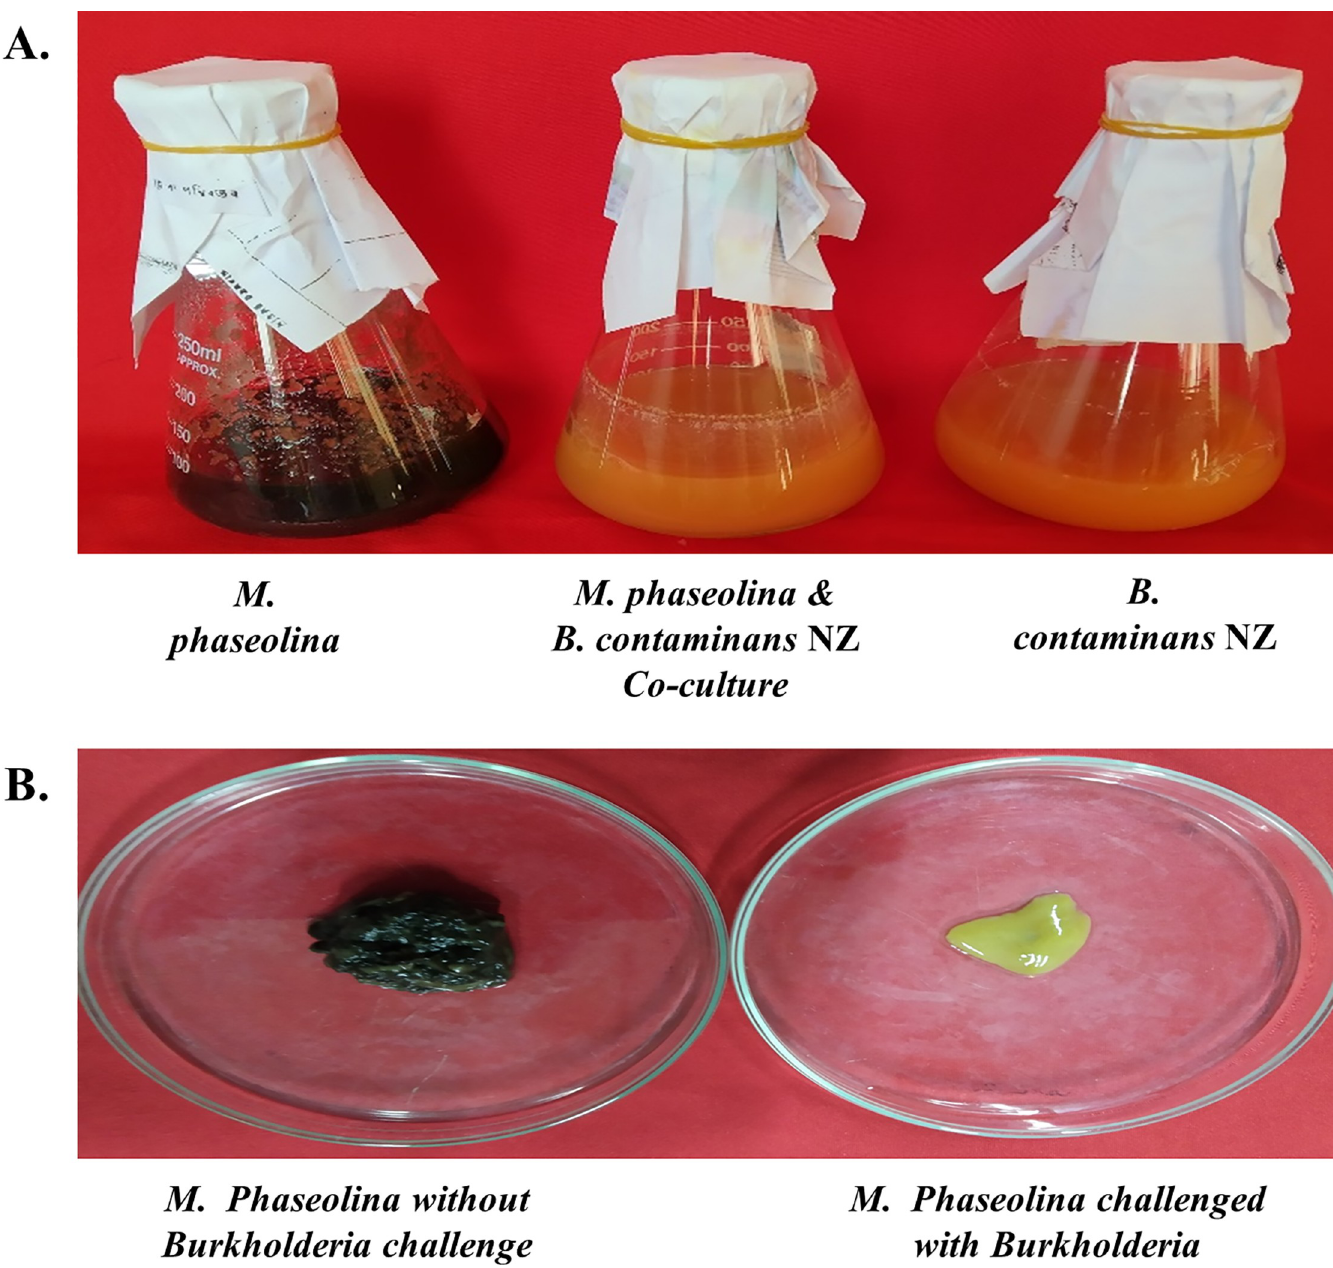
Fig 3. Chromogenic aberration in B . contaminans NZ challenged M . phaseolina . (A) M . phaseolina , B . contaminans NZ, and their co-cultures on day 5. (B) M . phaseolina without B . contaminans NZ retains the black color (left) compared to its B . contaminans NZ challenged counterpart (right). Inhibition of M . phaseolina growth and its pigmentation in the presence of B . contaminans NZ is evident compared to the culture containing only M . phaseolina .